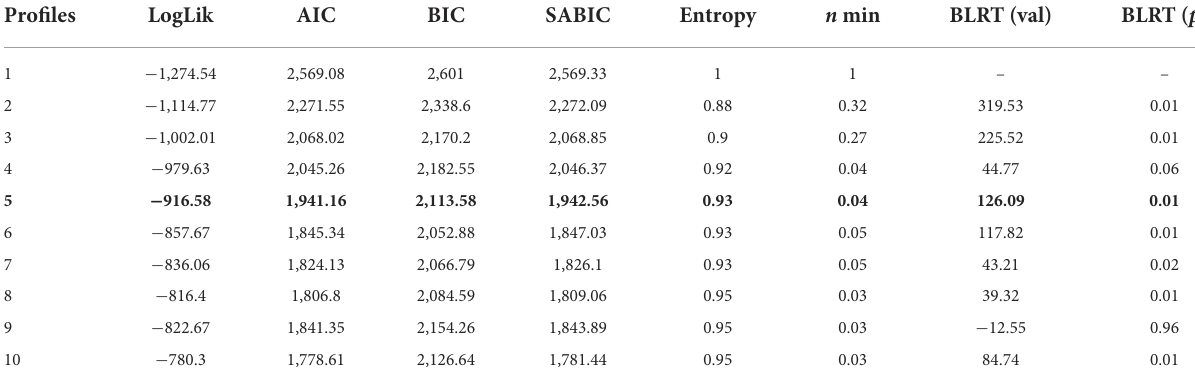
TABLE 2 Model fit indices from the latent profile analyses of co-care experiences at T2 ( N =